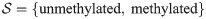
(a) EpiclomalBasic and (b) EpiclomalRegion graphical models.In (a), the shaded node Xnm denotes the observed methylation state at CpG site m of cell n. In (b), we take into account the region location of each CpG and let the shaded node Xnrl denote the observed methylation state at CpG site l of region r of cell n. Both Xnm and Xnrl take values in S={unmethylated,methylated} or simply S={0,1}. In (a) and (b), the unshaded Zn node corresponds to the latent variable (with a value in {1, …, K}) indicating the true cluster population (epiclone) for cell n. The Gkm and Gkrl unshaded nodes in (a) and (b) respectively are the latent variables with values in S that correspond to the true hidden CpG epigenotypes for each epiclone k. The unshaded μ, π, and ϵ nodes in both (a) and (b) correspond to the unknown model parameters, which under the Bayesian paradigm have prior distributions with fixed hyperparameters described by the shaded nodes with the 0 superscript. The distribution assumed for each variable or parameter is written within its node. The edges of the graphs depict dependencies. The plates depict repetitions. In EpiclomalBasic (a), true hidden epigenotypes share the same probability distribution across all CpG sites in the same epiclone (Gkm ∼ Bernoulli(μk)). In EpiclomalRegion (b), true hidden epigenotypes follow a Bernoulli distribution with probability parameters that vary across regions (Gkrl ∼ Bernoulli(μkr)).